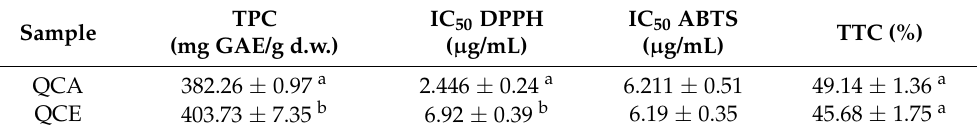
Table 2. Total polyphenolic content (TPC), total tannin content (TTC), and antioxidant